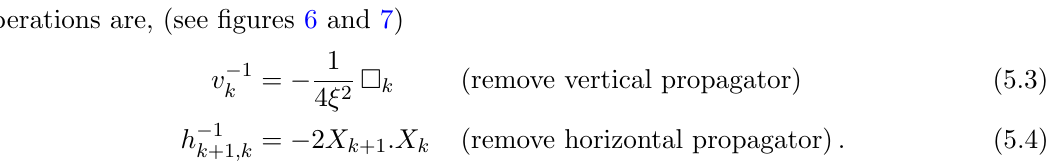
Figure 7 . Graphical representation of the action of the operators v (cid:0) 1 function. The operator v (cid:0) 1 removes a vertical (cid:30) 1 propagator, which is equivalent to the creation k of a magnon{anti-magnon pair on one site. Correspondingly, v k annihilates the magnon{anti- magnon